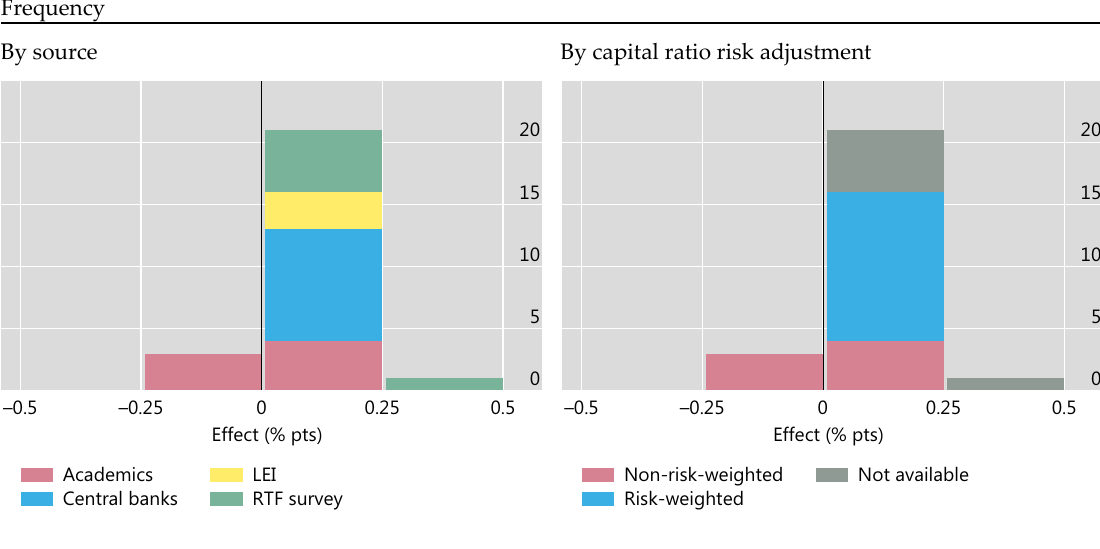
Figure 3. Effect of a one percentage point higher capital ratio on bank lending rates. Based on six RTF survey responses and 19 estimates from 11 studies (see references Almenberg et al. (2017), BCBS (2010), Benetton et al. (2017), Brooke et al. (2015), Cosimano and Hakura (2011), Dagher et al. (2016), Firestone et al. (2017), Glancy and Kurtzman (2018), Santos and Winton (2013), Slovik and Cournede (2011), Sutorova and Teply (2013)). Source: Financial Regulation Assessment: Meta Exercise, stats.bis.org/frame.